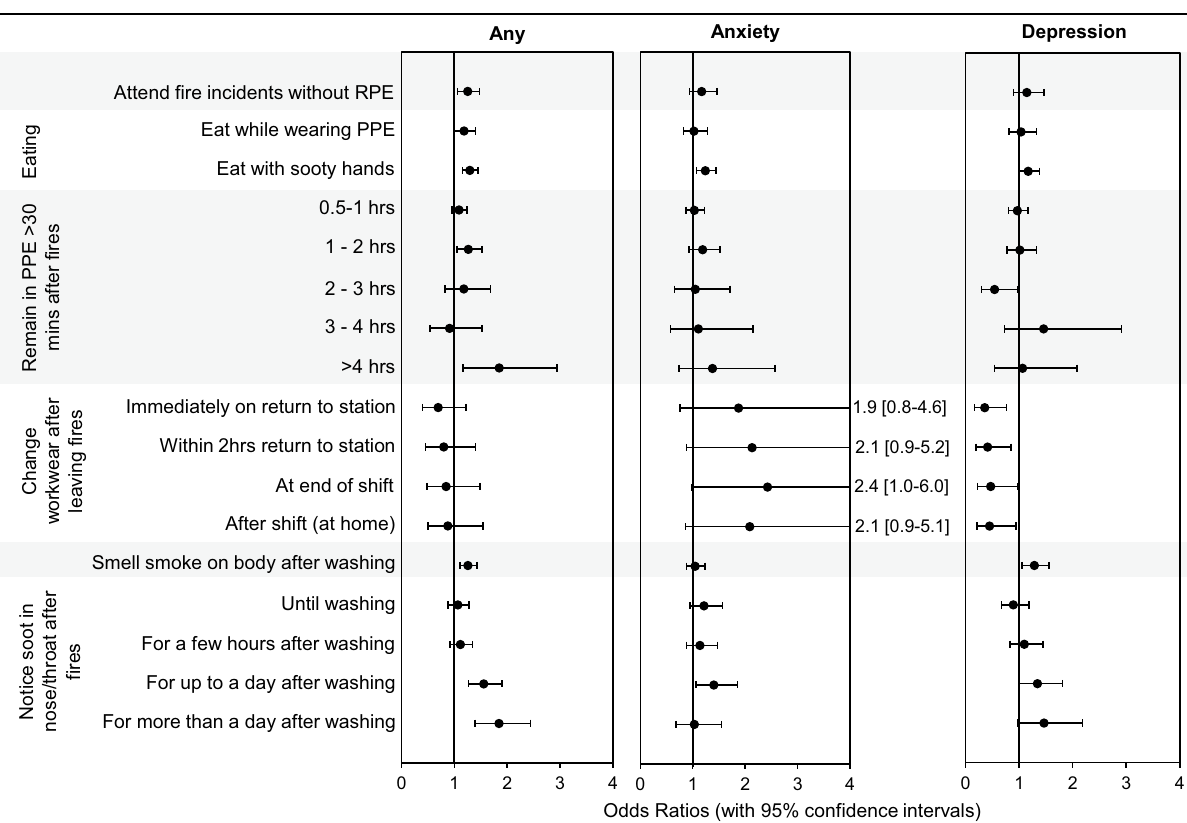
Figure 5. Firefighters’ Exposure to Contaminants During/After Fires and Mental Health Odds Ratios. Odds ratios (with 95% Confidence Intervals) were adjusted for various mental health risk factors (Supplementary File